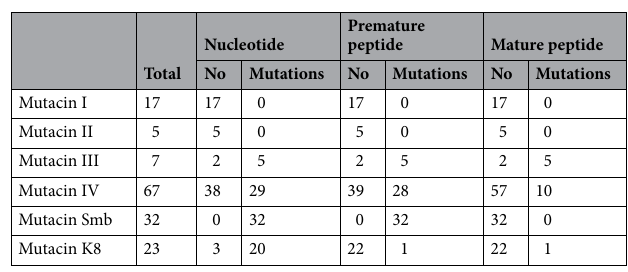
Table 2. The number of strains with mutations in nucleotide and peptide